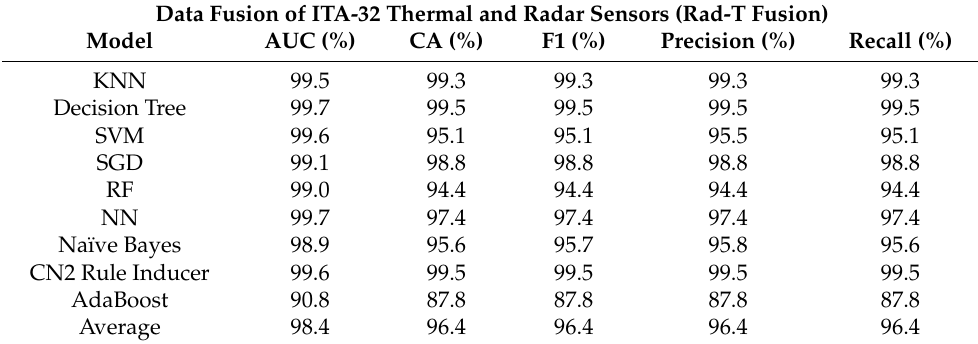
Table 5. Evaluation results of ITA-32 thermal and FMCW radar sensor data using a stratified 10-fold cross-validation and the average of classes. The fused data were obtained during sprained ankle rehabilitation